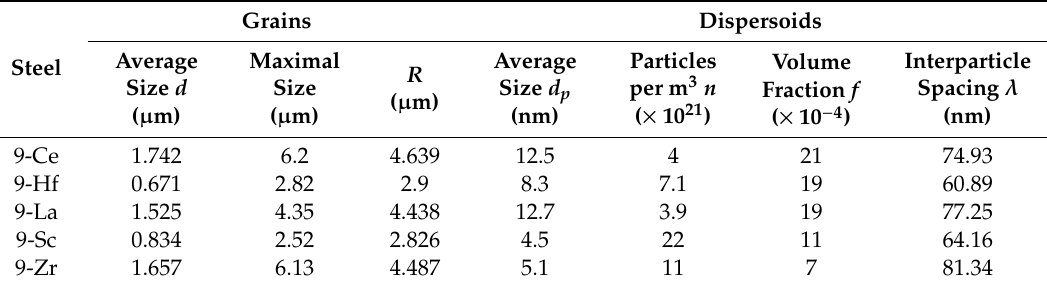
Figure 2. Gaussian fits of particle size distribution functions of 9Cr ODS steels with different types of oxide dispersoids. The BF-STEM micrographs of microstructures with fine dispersion (9-Sc) and coarse dispersion (9-Ce) of oxide particles. Table 3. Microstructural characteristics of the prepared steels.